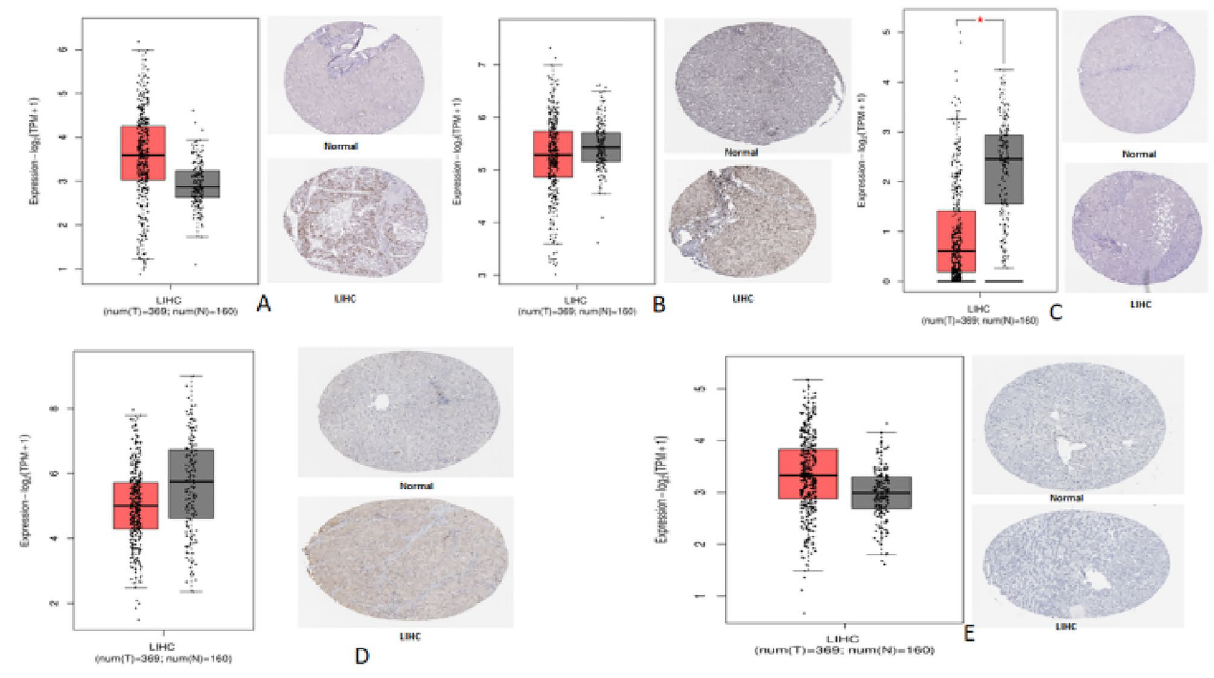
Figure 5. The mRNA expression and immunohistochemistry of the ( A) TP53 , ( B) AKT1 , ( C) ESR1 , ( D) JUN and ( E) CASP3 in normal liver tissues and HCC tissues from the GEPIA2 (http:// gepia2. cancer- pku. cn/# index) and HPA database (https:// www. prote inatl as. org/). The gray bars in box plots represent normal samples; the red bars in box plots represent tumor samples(* p <